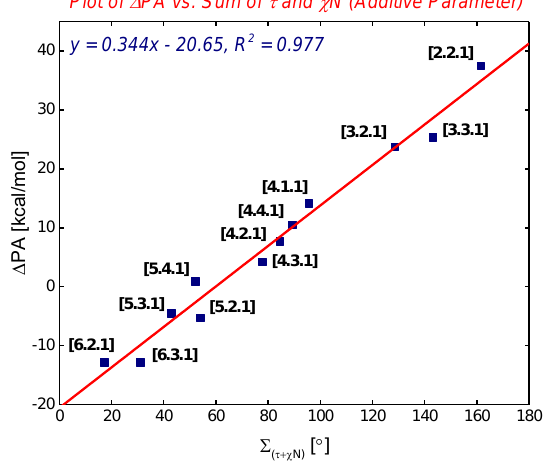
Figure 4. Plot of ∆ PA (PA = Experimental Protonation Affinity) to the Sum of Twist and Pyramidalization at Nitrogen Angles (Additive Winkler-Dunitz Parameter: Σ τ + χ N ). Note that ( Σ τ + χ N ) gives linear correlations vs. structural and other energetic parameters. See [15]. Also note comprehensive studies [16–18].